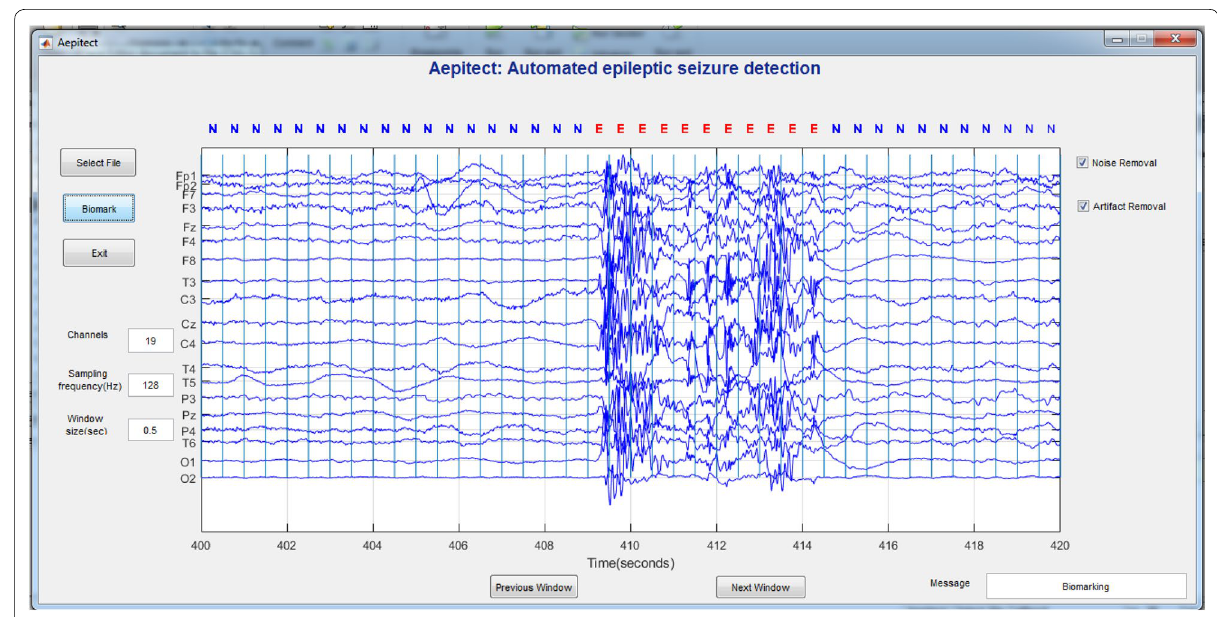
Fig. 6 Screenshot of GUI referred as ‘Aepitect’ developed in MATLAB